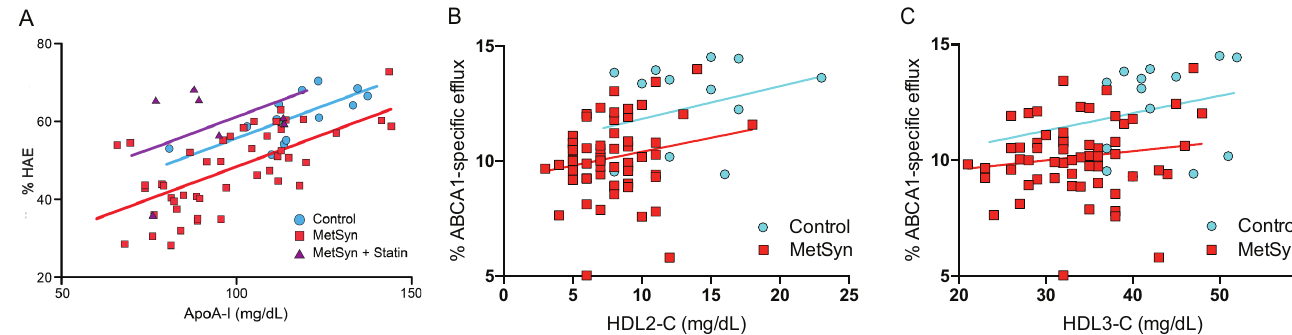
Fig 3. HAE is reduced independent of apoA-I levels in MetSyn patients. Multiplelinear regressionplot of the predictors of HAE with respect to apoA-I in control, MetSyn, and MetSyn + Statin subjects. Multiplelinear regressionmodel of HAE was adjustedfor apoA-I, MetSyn status, and statin use. The slope of the regression lines was similar for each group (~0.33), indicatingan absenceof